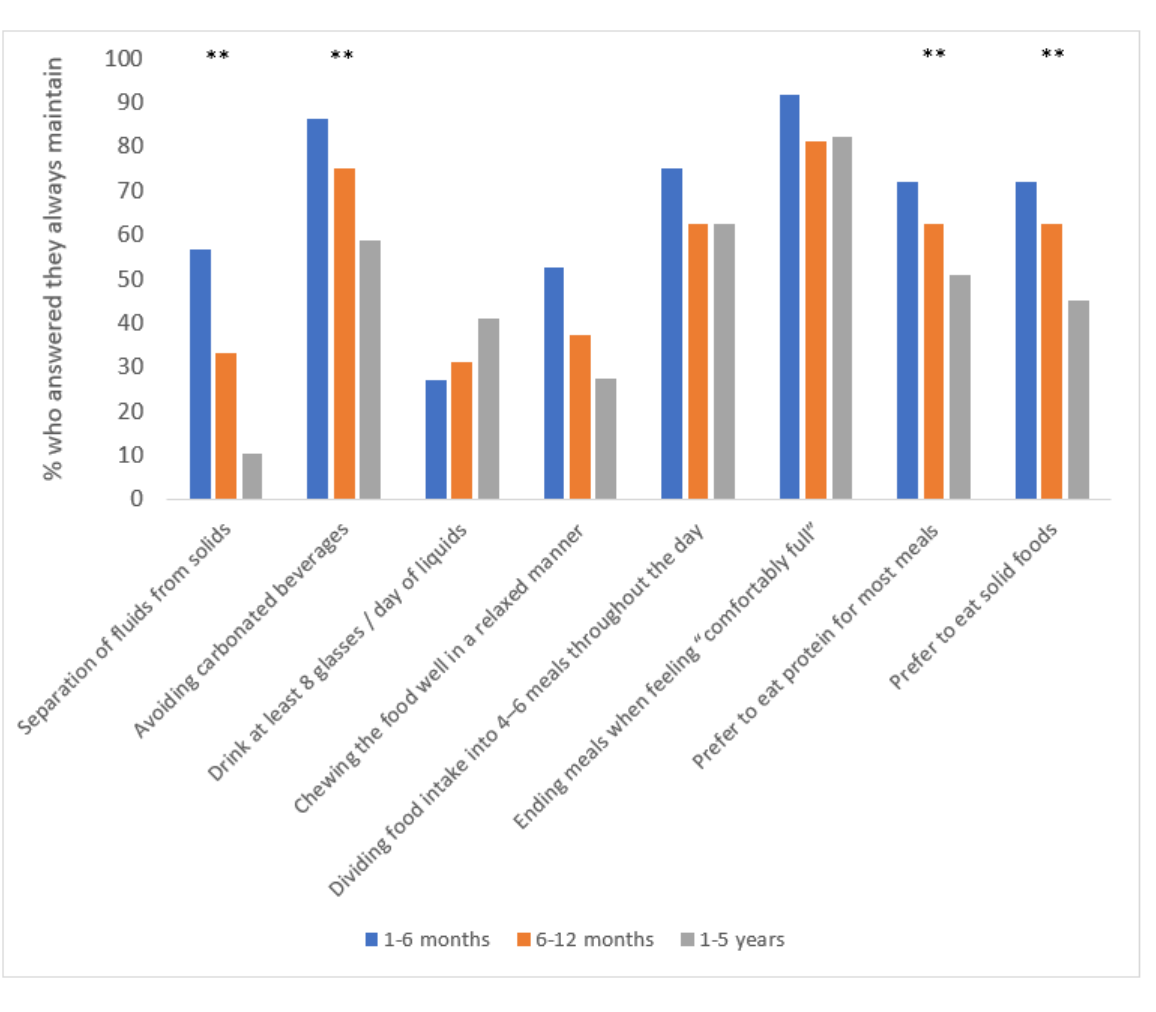
Figure 2. ( a ): Adherence to bariatric surgery eating recommendations grouped by time elapsed since surgery (Israel) 1,2,3,4 . ( b ): Adherence to bariatric surgery eating recommendations grouped by time elapsed since surgery (Portugal) 1,2,3,4 . 1 Data were available for participants from Israel and Portugal for n = 100 and n = 37 respondents between 1–6 months post-surgery, n = 56 and n = 16 respondents between 6–12 months post-surgery, and n = 103 and n = 51 respondents between 1–5 years post-surgery, respectively. 2 Patients were asked if they keep the following recommended behaviors for the last month (always maintained/partially maintained/not maintained). 3 A glass of drink was considered as 200 mL. 4 Preference to eat solid food items (e.g., boiled egg, chicken breast, salad) over soft or crunchy food items (e.g., ice cream, cookies, cakes, cookies) in most meals. ** Significant differences between time elapsed since surgery groups. Table 3. Postoperative health behaviors grouped by time elapsed since surgery and by country. Parameters